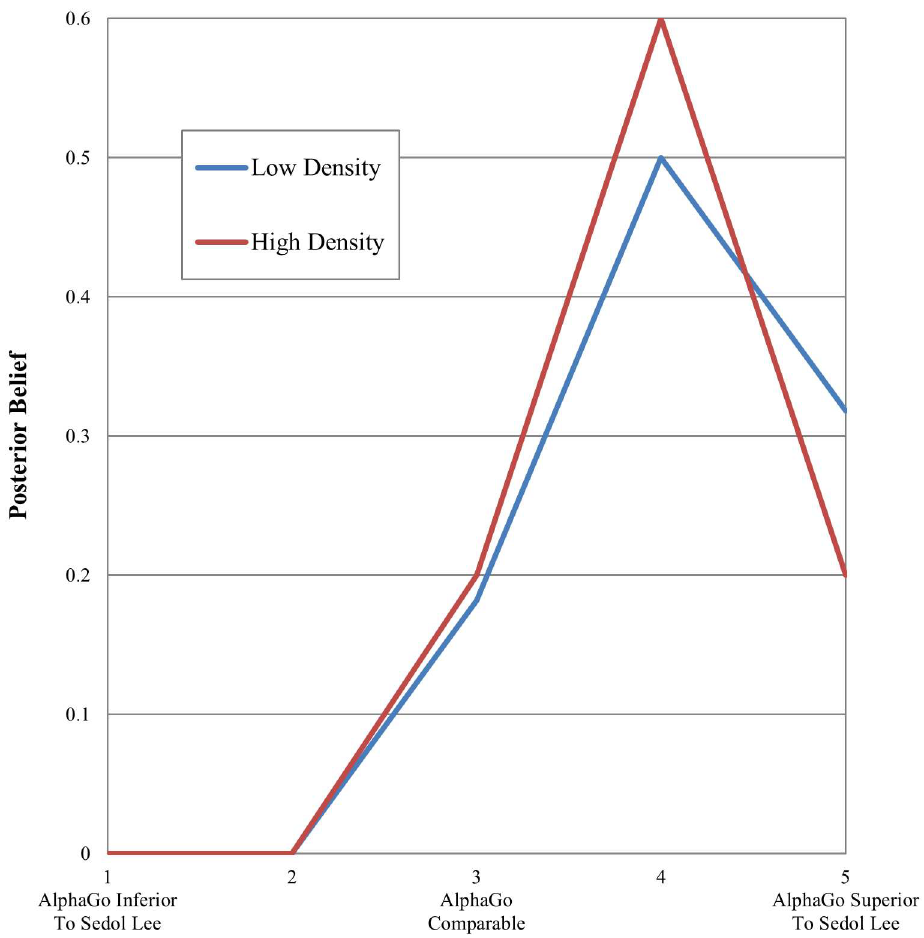
Fig 8. Posterior belief over the go capability of Sedol Lee. Y axis refers to a proportionof the participants for a given level of posterior belief in Lee’s capability. N =